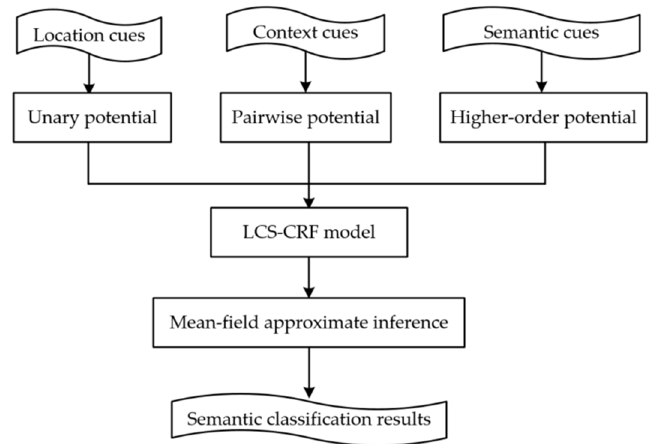
Figure 5. Flowchart of the LCS-CRF-based semantic classification in this study.